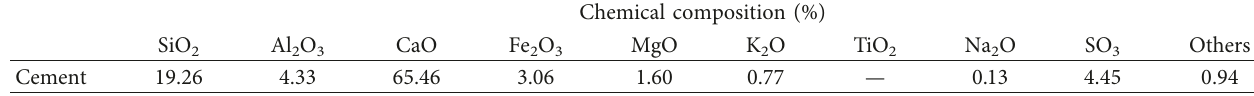
Table 1: Chemical composition of ordinary Portland cement (P. O42.5R).